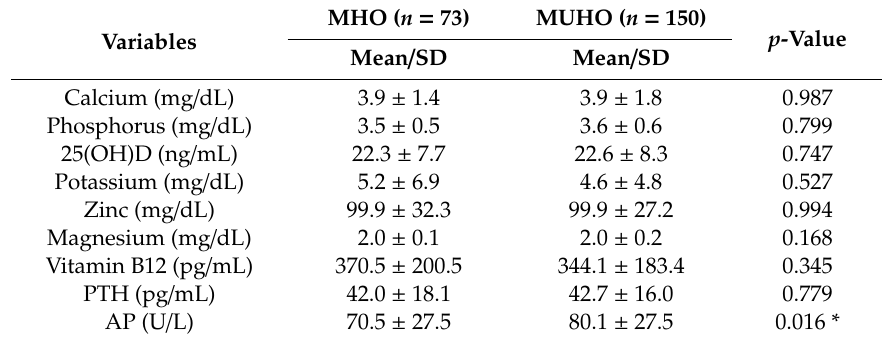
Table 2. Profile of biomarkers and micronutrients of bone metabolism according to the MHO and MUHO phenotypes.